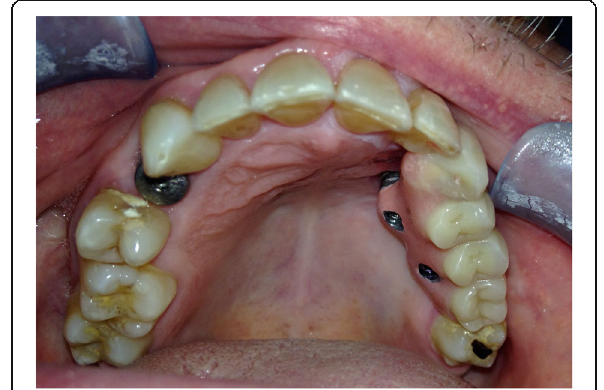
Fig. 4 Pt no. 1. The final screw-retained prosthesis placed after 3 months